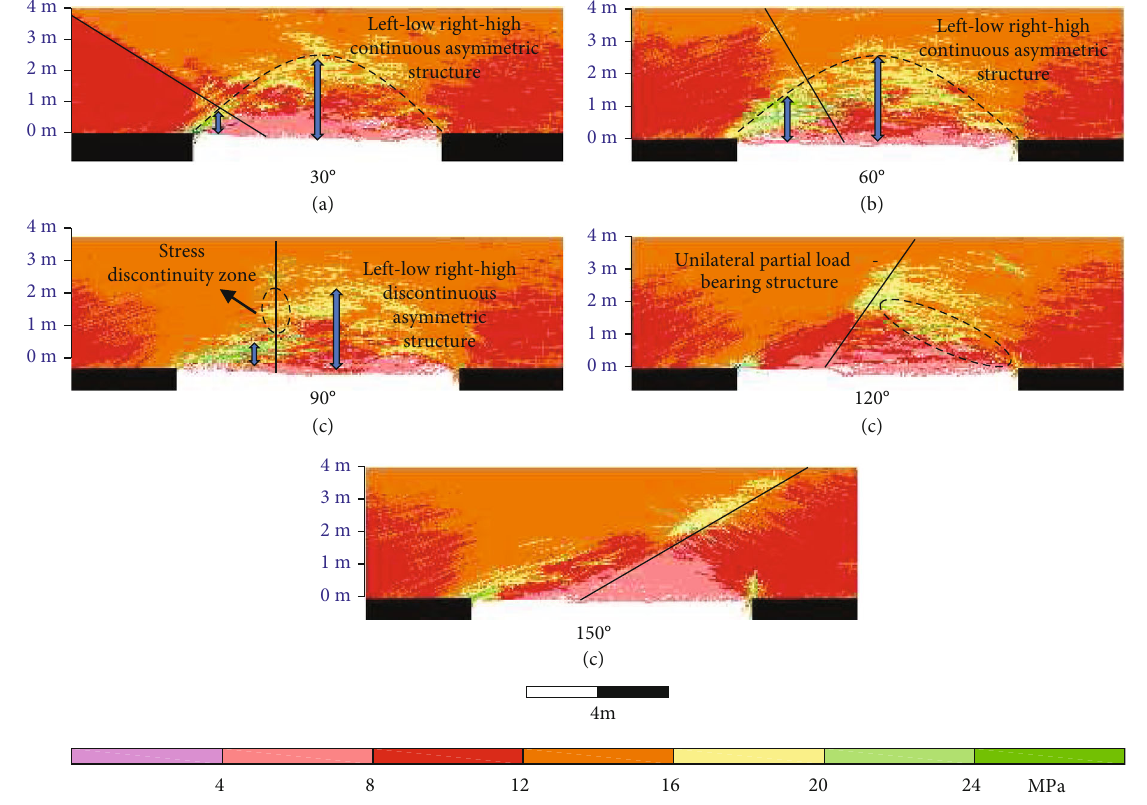
Figure 19: Vector illustration of maximum principal stress under di ff erent discontinuity surface